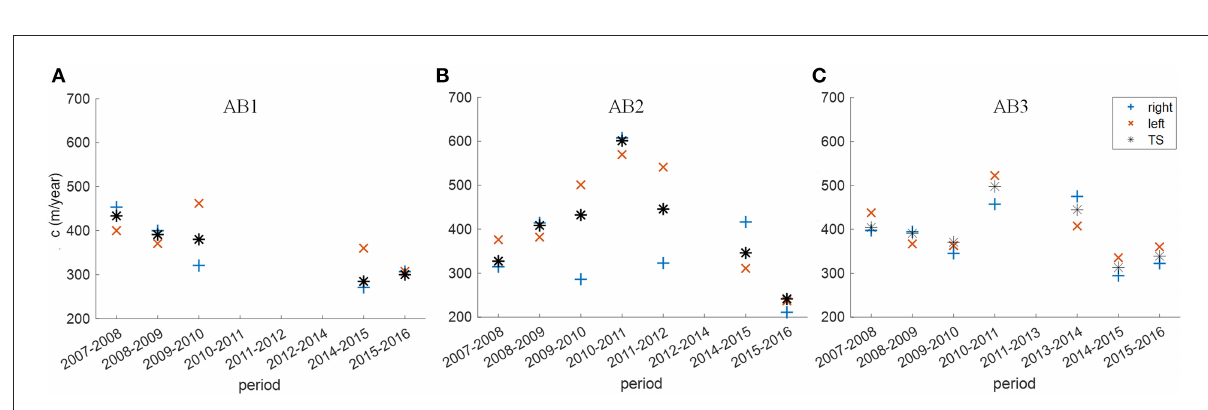
rather mild curvature, or were straight, the longitudinal spacing between the points in the 20 outer right and left longitudinal profiles was assumed to be constant as these distances were much shorter than the bar lengths. We are aware of the fact that the profile points were, strictly speaking, not equidistantly spaced as the distance between successive points along each longitudinal profile depends on river curvature and centerline distance (cf. Figure 4). However, the main scope of our analysis is on the comparison of bar characteristics of the same